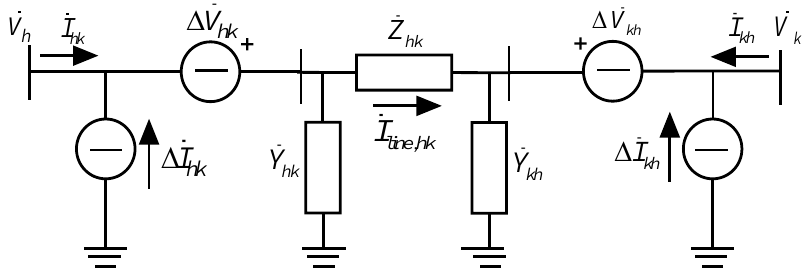
Figure 2. Modelling of the generic “h-k” connection accounting for FACTS compensations.